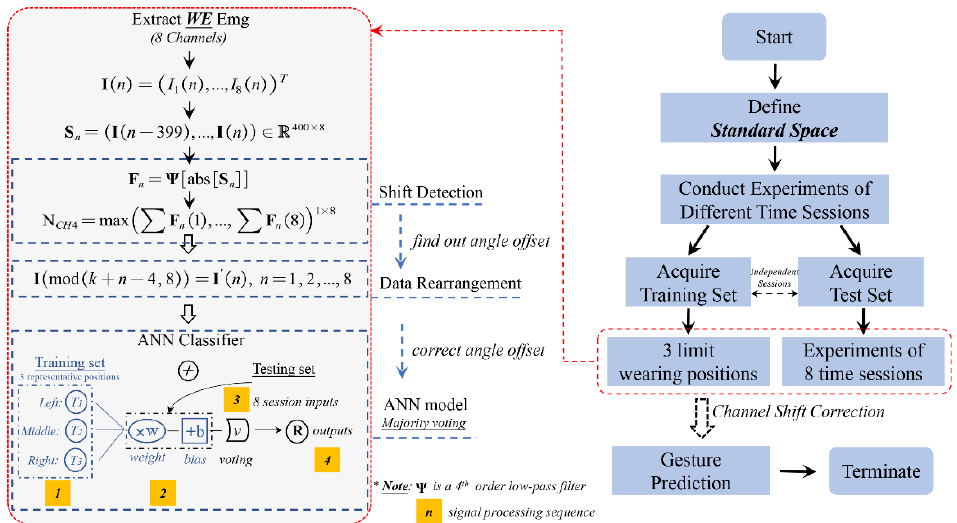
Figure 1. Scheme of adaptive channel shift strategy using preprocessed data plus improved ANN classifier with majority voting method. The electrode shifting position can be identified only using the predefined synchronous gesture, and once the changed configuration is established during acquiring training data from three representative wearing positions, the subject does not require further recalibrate the algorithm on one session.